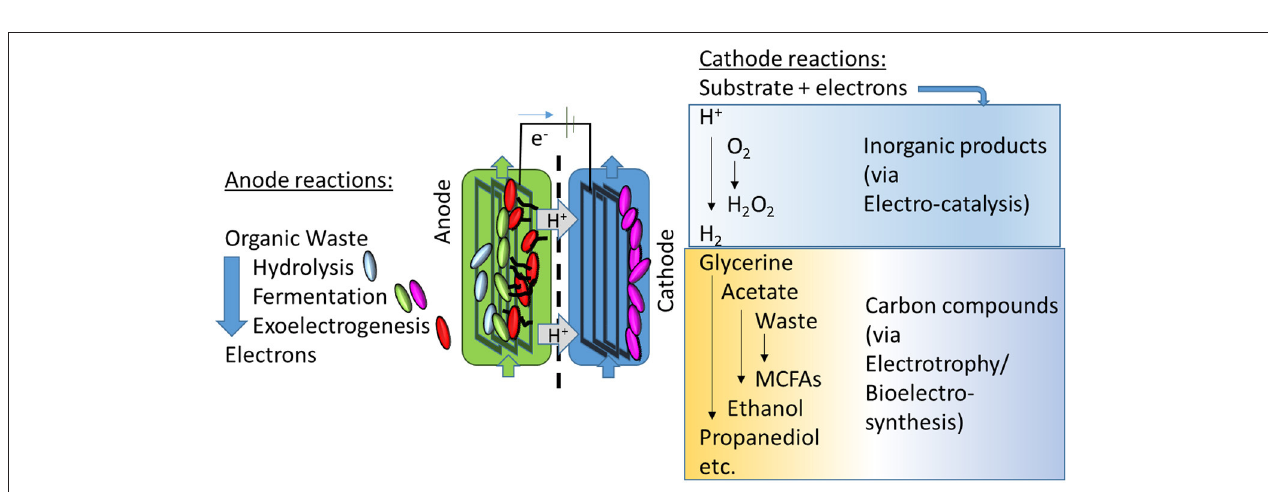
FIGURE 3 | A flow chart for a Bio-Electro-Refinery showing production of switchgrass bio-oil, chemical manipulation including pH neutralization, followed by phase separation using centrifugal contactor, and chemical production in a BES using the acid-rich aqueous phase. (NBOOP: neutralized bio-oil organic phase, NBOAP: neutralized bio-oil aqueous phase). [Switchgrass photo: https://www.gardenia.net/rendition.slider_detail/uploads/plant/1433256670-603d263a69fa7639a/Panicum_ virgatum_Cloud_Nine_2009_09.jpg].